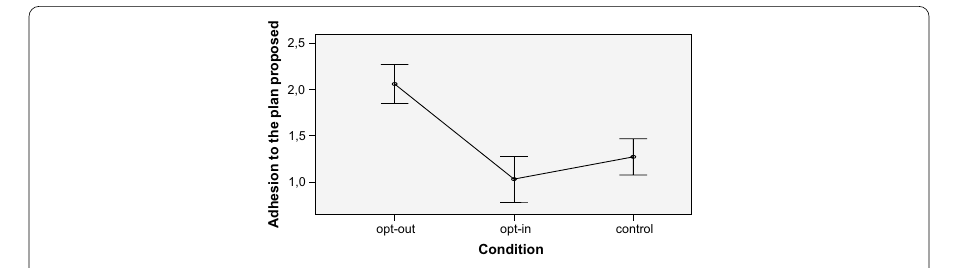
Fig. 1 Effect of default options on the intention to invest